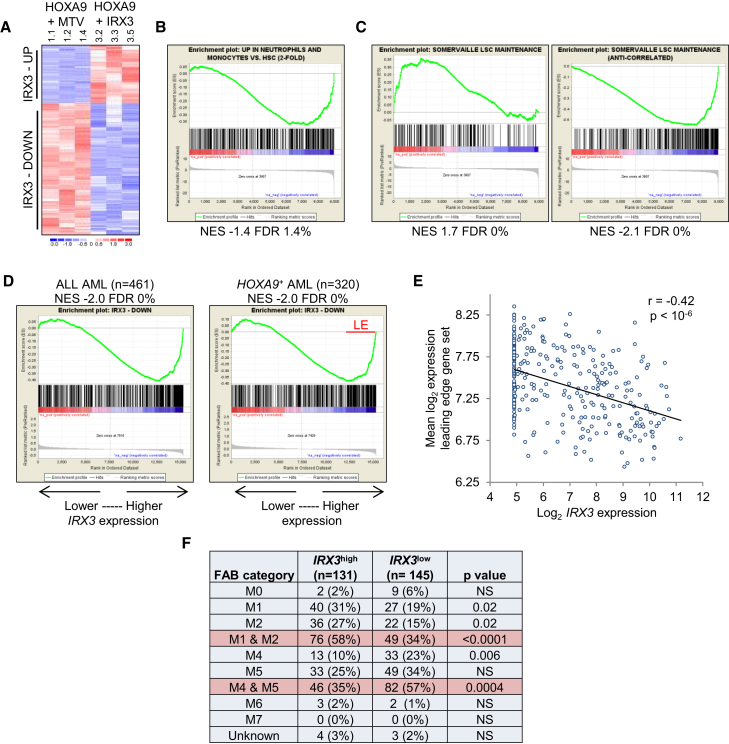
IRX3 Represses a Myelomonocytic Differentiation Program in Murine and Human AML(A) Heatmap shows differentially expressed protein-coding genes (p < 0.05, unpaired t test, >2-fold).(B–D) GSEA plots show enriched expression of (B) mature myelomonocytic genes, (C) LSC maintenance signature genes, and (D) IRX3-repressed genes in (B and C) Hoxa9/MTV versus Hoxa9/IRX3 AML cells or (D) primary human AMLs ranked by IRX3 expression, respectively.(E) Scatterplot shows expression of IRX3 in primary human HOXA9+ AML samples versus mean log2 expression level for the leading-edge gene set shown in (D).(F) Morphologic classification of IRX3high versus IRX3low primary HOXA9+ AML samples (Wouters et al., 2009). p values were calculated using Fisher’s exact test.See also Figure S5 and Tables S5, S6, and S7.